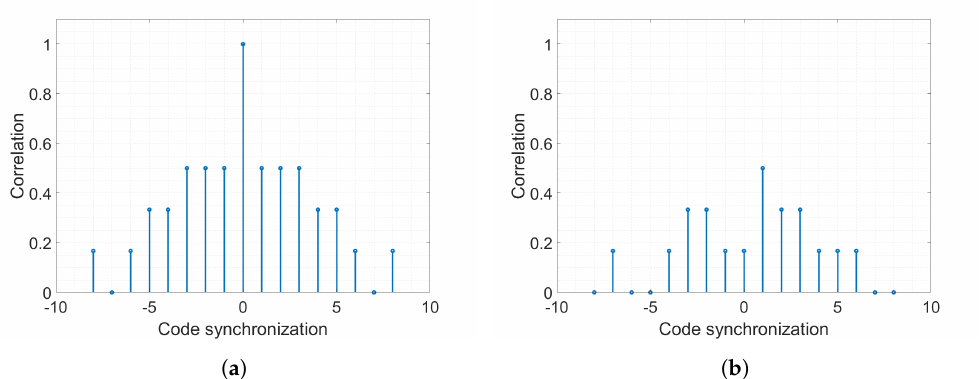
Figure 10. Auto-correlation and cross-correlation properties of the Pseudo Noise Codes. ( a ) PN codes auto-correlation property. ( b ) PN codes cross-correlation